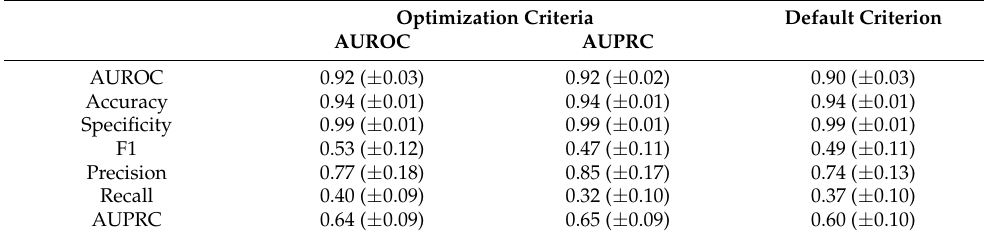
Table 5. Model validation.